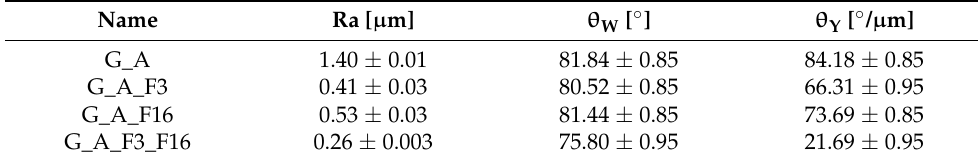
Figure 8. Surface roughness profiles of G_A, G_A_F3, G_A_F16, and G_A_F3_F16 samples. Table 2. Roughness values of Ra and comparison of the contact angles of Wenzel ( θ W ) and Young ( θ Y ) of the